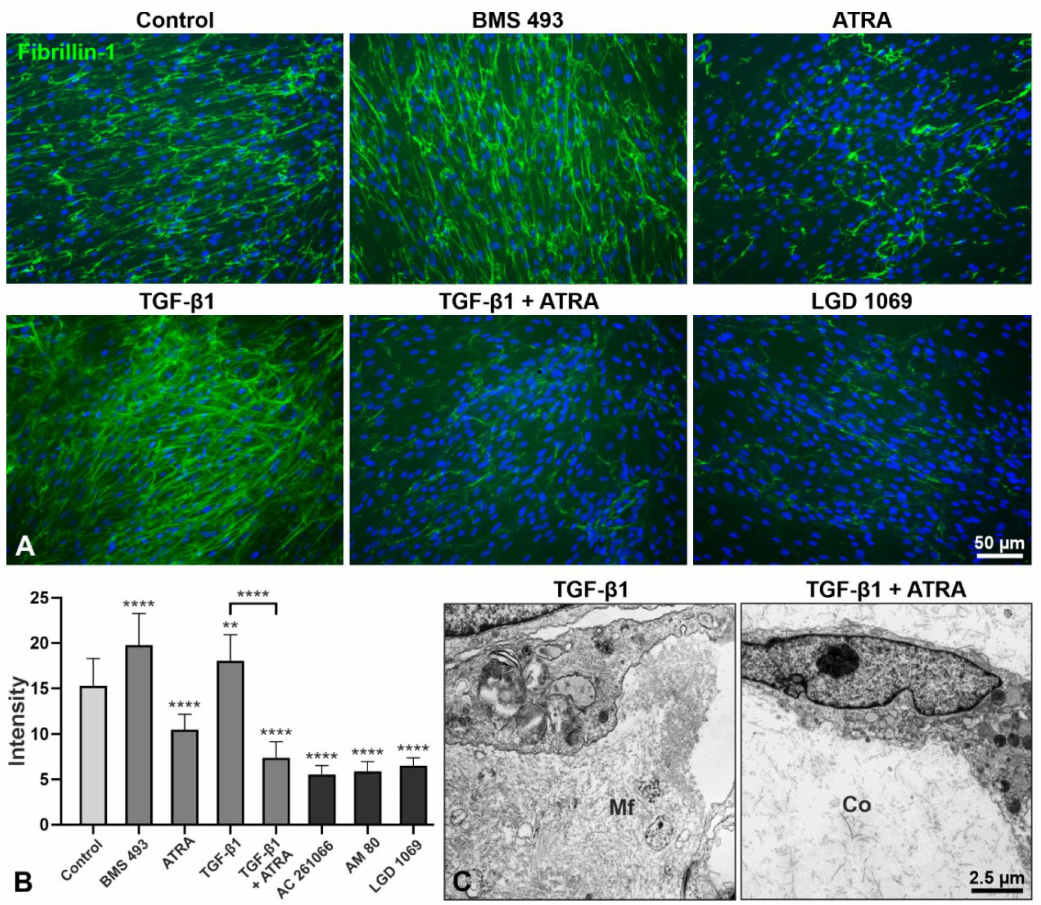
Figure 9. Immunofluorescence analysis of microfibrillar network assembly in response to retinoic acid pathway inhibition and activation. ( A ) Immunolabeling for fibrillin-1 (green fluorescence) in cultures of human Tenon’s capsule fibroblasts (hTCF) treated with 5 µ M of BMS 493 (pan-RAR antagonist), 2 µ M all- trans retinoic acid (ATRA), 5 ng/mL transforming growth factor- β 1 (TGF- β 1), 5 ng/mL TGF- β 1 together with 2 µ M ATRA, or 10 µ M of LGD 1069 (pan-RXR agonist) for 7 days; untreated cells served as control; nuclear counterstaining with 4 (cid:48) ,6-diamidino-2-phenylindole (DAPI, blue fluorescence). ( B ) Quantitative analysis of fluorescence intensity of fibrillin-1 staining across whole images (n = 20 per group). Data are expressed as means ± SD (** p < 0.01, **** p < 0.0001; unpaired t -test). ( C ) Transmission electron micrographs showing the production of microfibrils (Mf) by hTCF cultivated in 3D collagen (Co) gels following treatment with 5 ng/mL TGF- β 1 for 10 days. The addition of 2 µ M ATRA to TGF- β 1 inhibited the deposition of microfibrils within the collagen